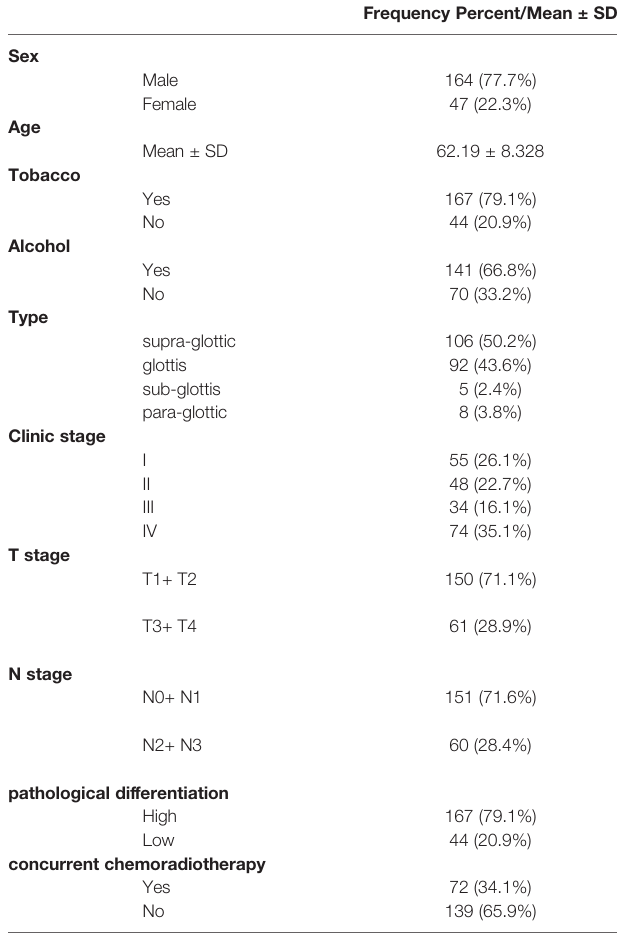
TABLE 1 | Summary of baseline